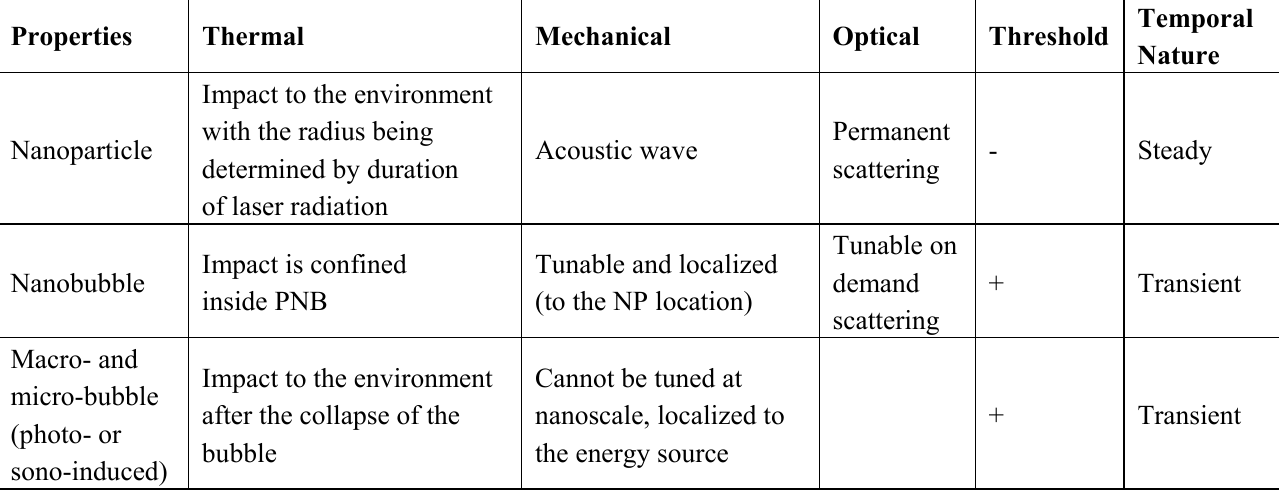
Table 1. Comparison of the properties of plasmonic nanoparticles, vapor bubbles and plasmonic